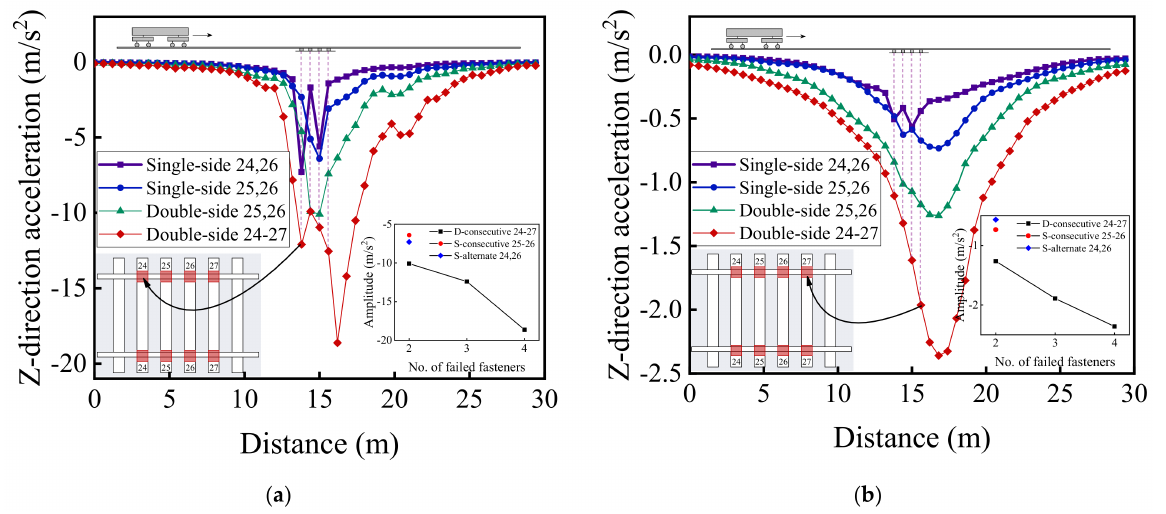
Figure 29. The longitudinal variations of vertical acceleration responses of ( a ) sleepers and ( b ) ballast layer under the left rail with different patterns of rail fastener